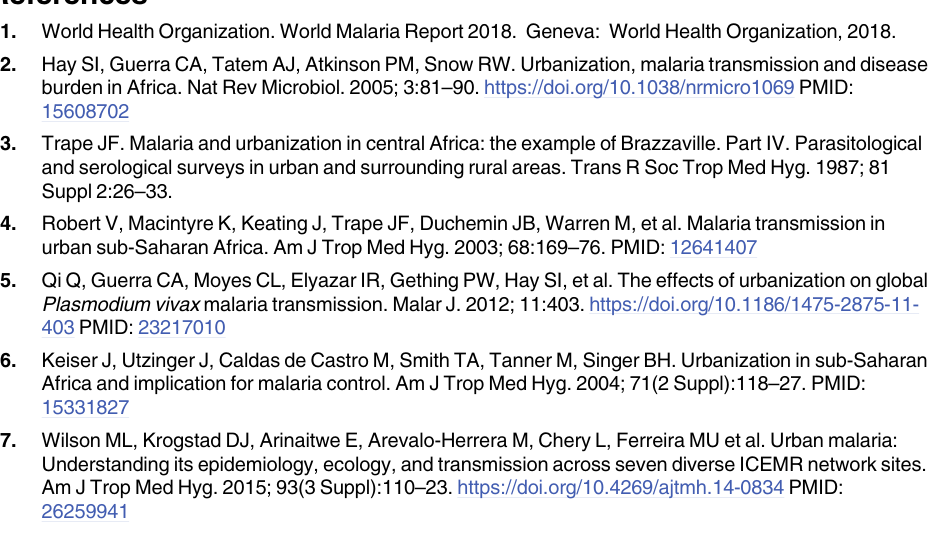
S1 Table. Independent predictors of malaria incidence in urban Maˆncio Lima, Brazil, iden- tified by multivariable RE-ZINB regression analysis without the spatial covariate (zone of